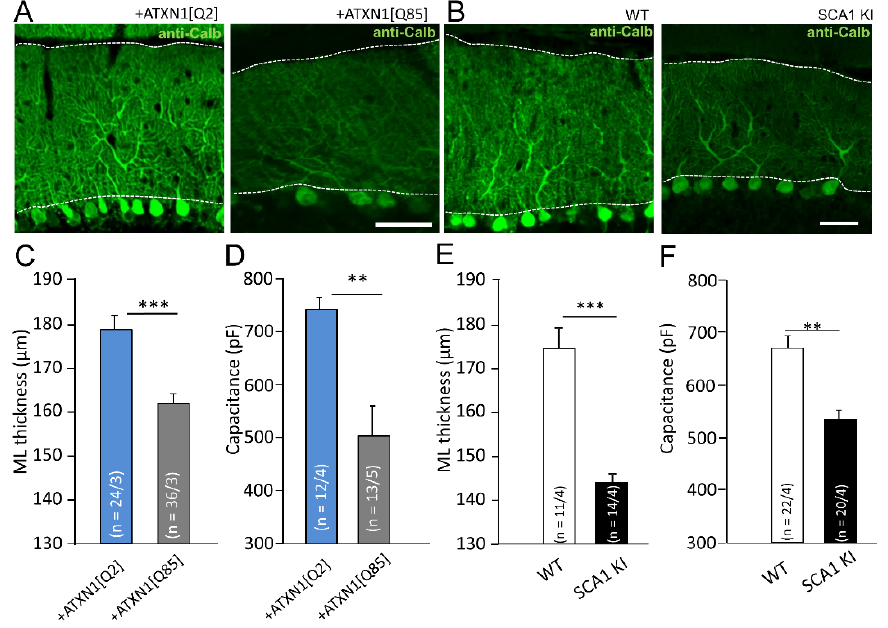
Figure 2. Mutant Ataxin-1 induces changes in PC morphology in SCA1 models. ( A , B ) Confocal images of cerebellar cortex labeled with anti-Calbindin (anti-Calb, PCs marker) show collapse of the molecular layer (ML) in mice that express ATXN1[Q85] selectively in BG ( A ) and in SCA1 KI mice ( B ). ML is marked by dotted lines. Scale bar 50 µ m. Average ( C ) depth of ML and ( D ) capacitance of PCs are reduced in mice that express ATXN1[Q85] selectively in BG and in SCA1 KI mice ( E , F ). The number (n) of tested areas or PCs and animals (areas/animals) or (PCs/animals) are shown in parentheses. Asterisks indicate a statistically significant difference compared to respective controls ( t -test; ** p < 0.01; *** p < 0.001). Table 1. Passive electrophysiological properties of PCs from 12-week-old mice. Cm – membrane resistance, Ra – access resistance, Rm – membrane resistance. t -test indicates significant effects in Cm. n —number of cells/number of animals, ** p < 0.001; ††† p < 0.001. Genotype Cm (pF) Ra (m Ω ) Rm(mΩ) WT ( n = 20/8)